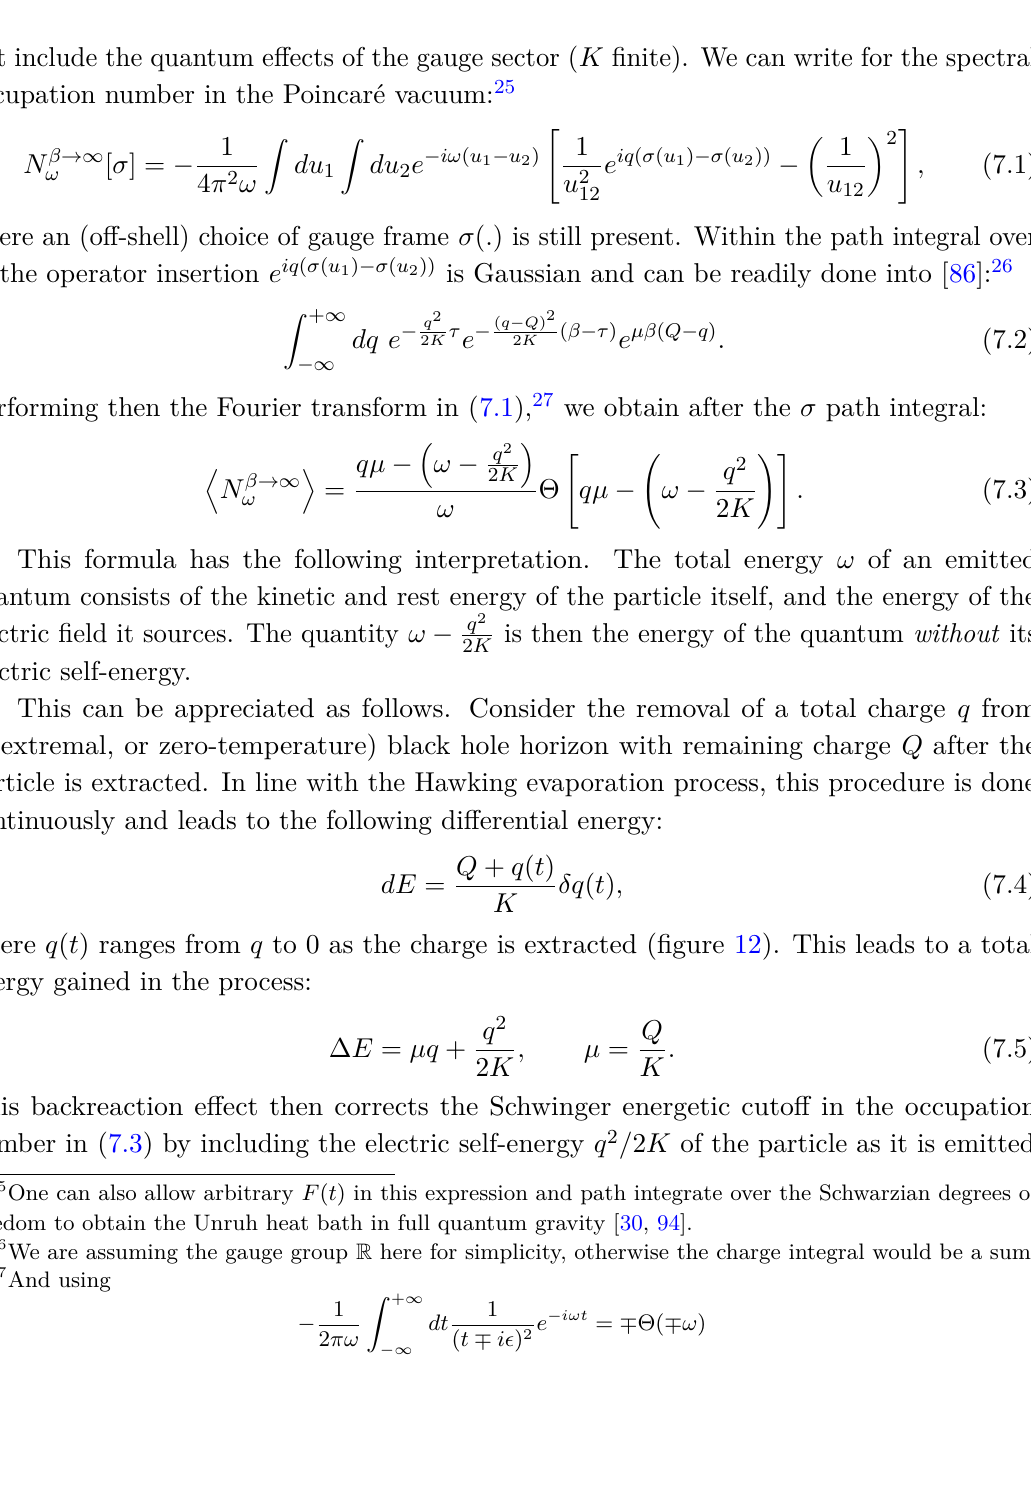
Figure 12 . Continuous extraction of charge δq from a charged system of charge Q + q ( t ) where q ( t ) starts off at q and then shrinks as charge is extracted until it reaches 0